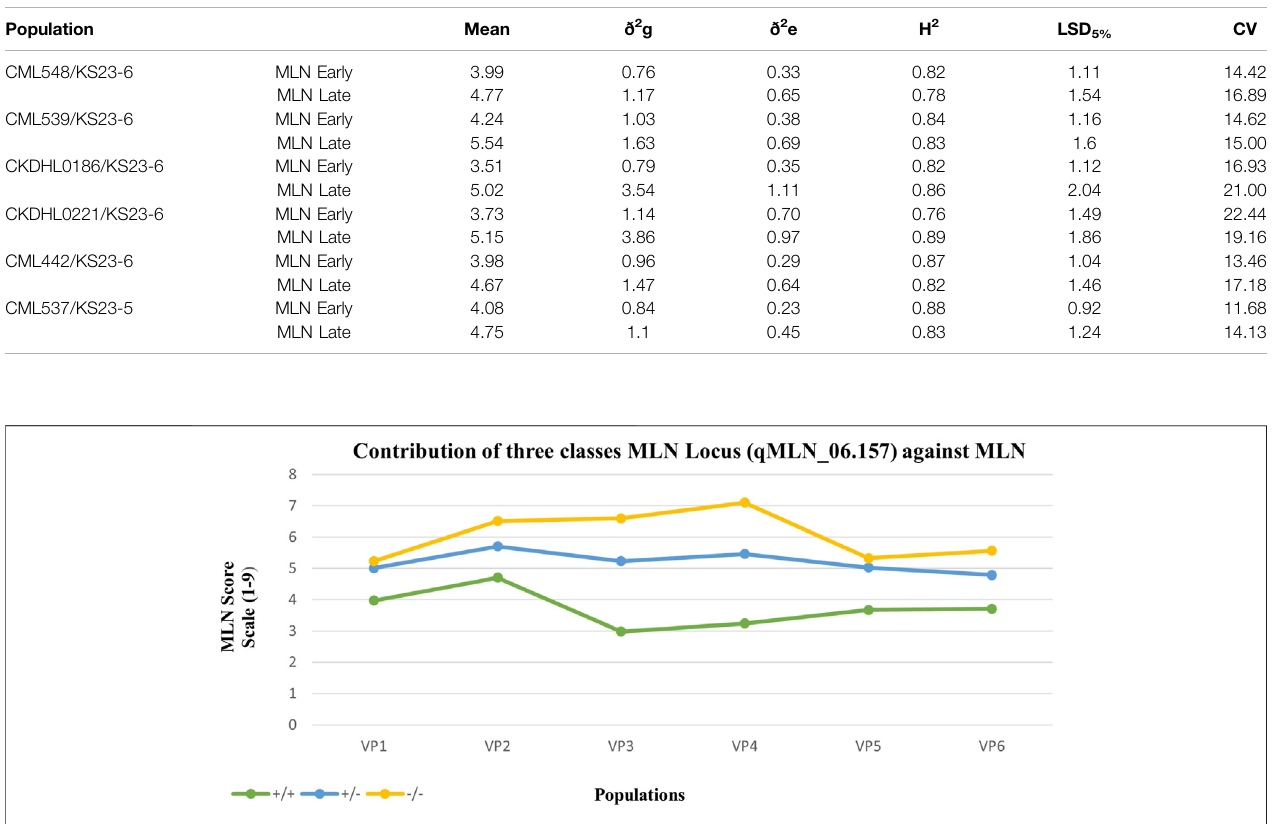
FIGURE6| MeanresponsetoMLNinoculationofindividuals fromcontrastingmarkerclasseswithinsixpopulations. +/+ arehomozygousfortheKS23haplotype, +/ − are heterozygous, and − / − are homozygous for the susceptible haplotype. All populations were genotyped with 20 SNP markers identi fi ed along the MLN-resistant QTL region on chromosome